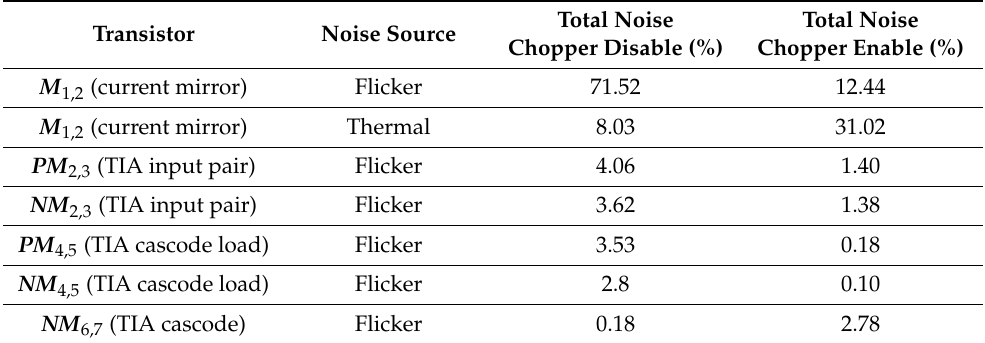
Table 1. Simulated noise contributors.